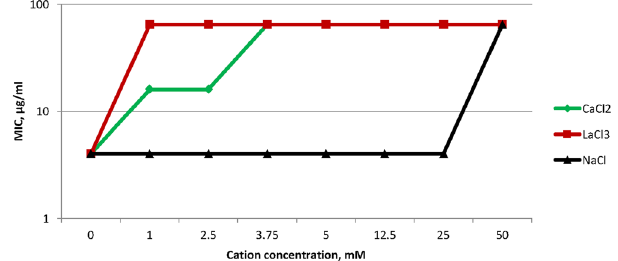
Figure 1. Inhibition of C4 activity by cations. MICs of C. albicans were determined for C4 in the presence of increasing concentrations of NaCl, CaCl 2 or LaCl 3 . The initial MIC under standard conditions is 4 µ